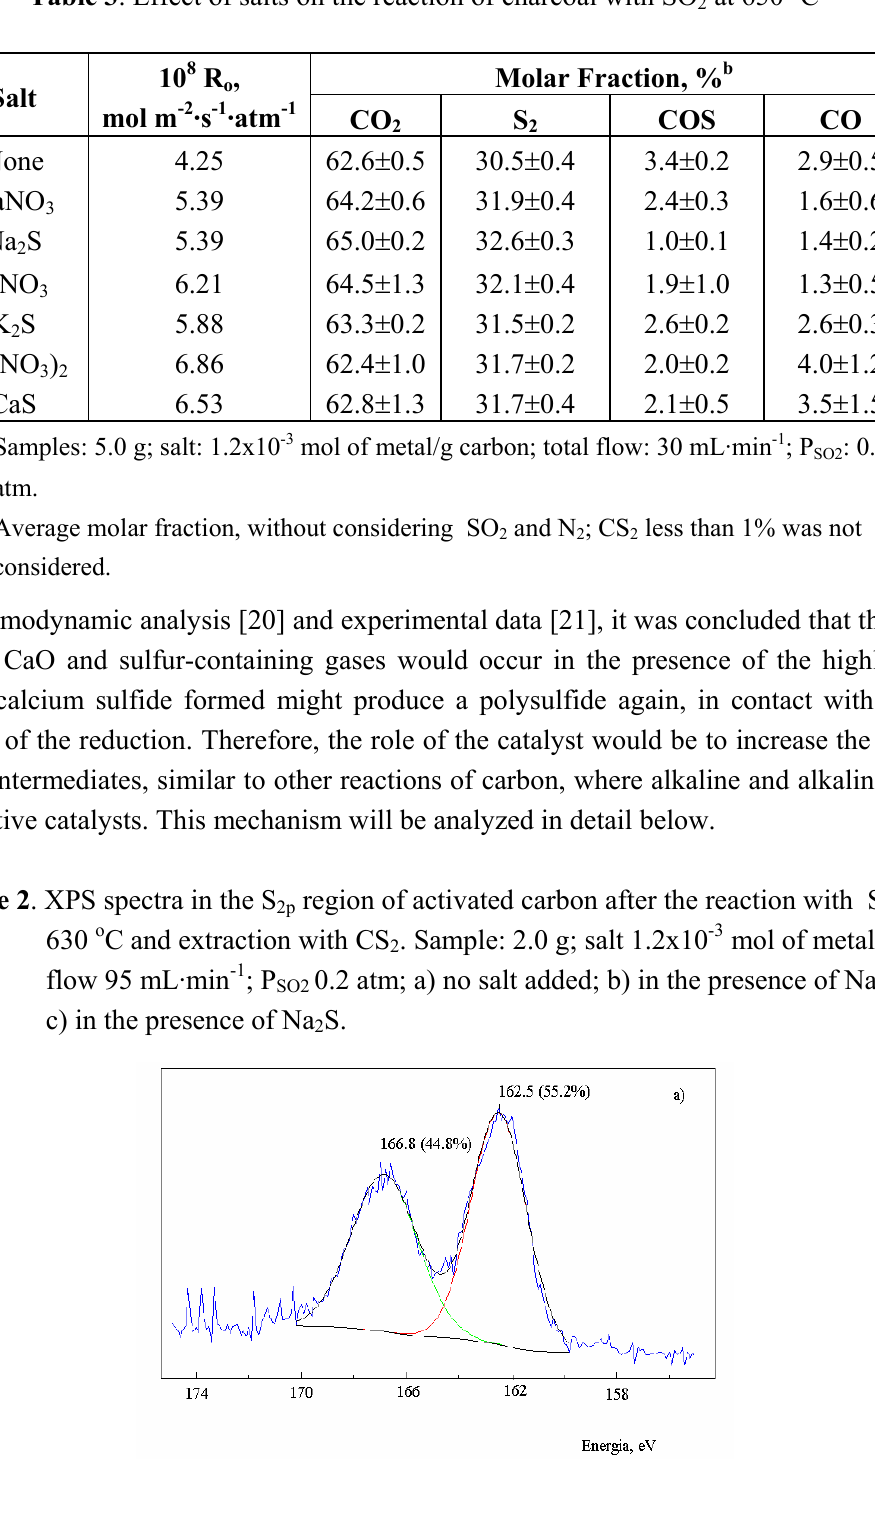
Table 3 . Effect of salts on the reaction of charcoal with SO